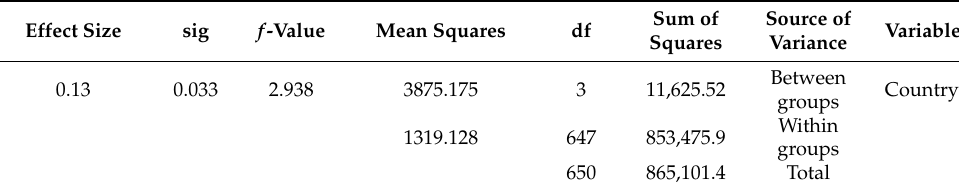
Table 2. Differences among countries in anxiety about COVID-19 infection.